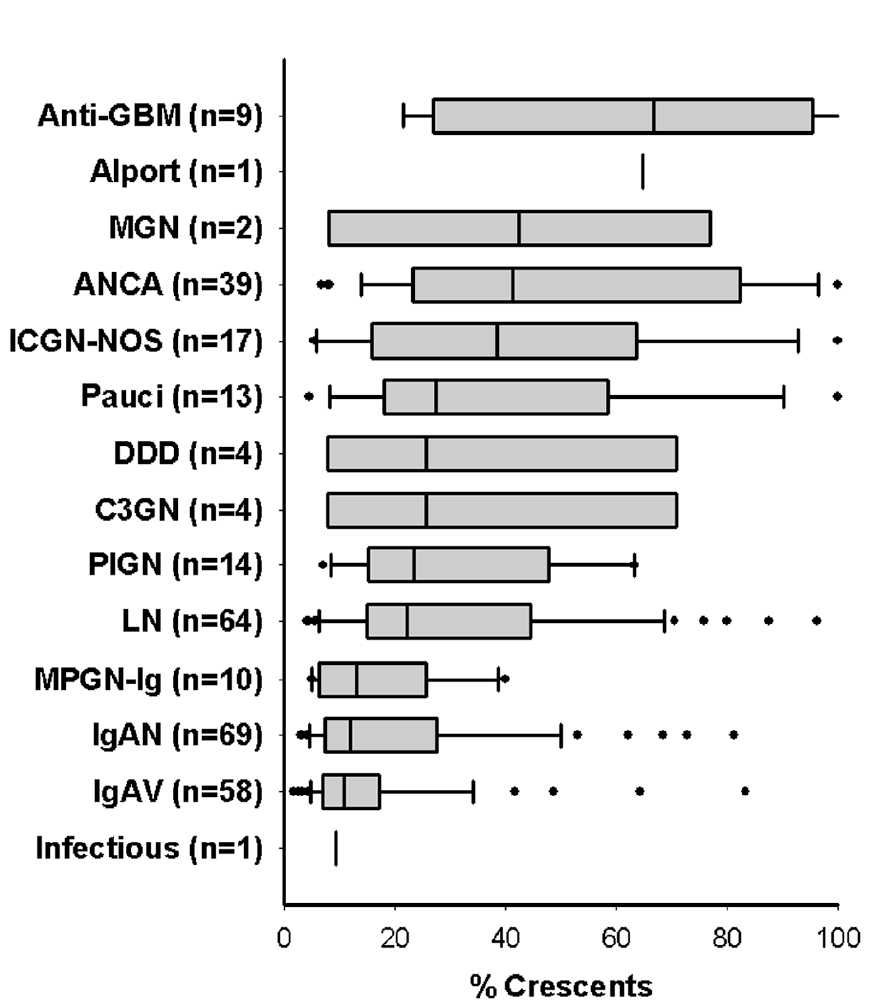
Figure 2. Percent crescents in children with glomerulonephritis and crescents, stratified by etiology. Median percentage of glomerular crescents are shown for all 305 children in the study. Boxes and whiskers represent IQR with 5th and 95th percentiles. Etiologies: anti-glomerular basement membrane disease (anti-GBM), membranous GN (MGN), anti-neutrophil cytoplasmic antibody associated nephritis (ANCA), immune complex GN not otherwise specified (ICGN-NOS), dense deposit disease (DDD), C3 glomerulopathy (C3GN), post-infectious GN (PIGN), lupus nephritis (LN), Ig-predominant membranoproliferative GN (MPGN-Ig), IgA nephropathy (IgAN), IgA renal vasculitis (IgAV). Percentage of crescents also correlated inversely with eGFR at biopsy (R = − 0.48, p < 0.001) and the eGFR at 1-year (R = − 0.49, p < 0.001). When stratified by etiology, this correlation